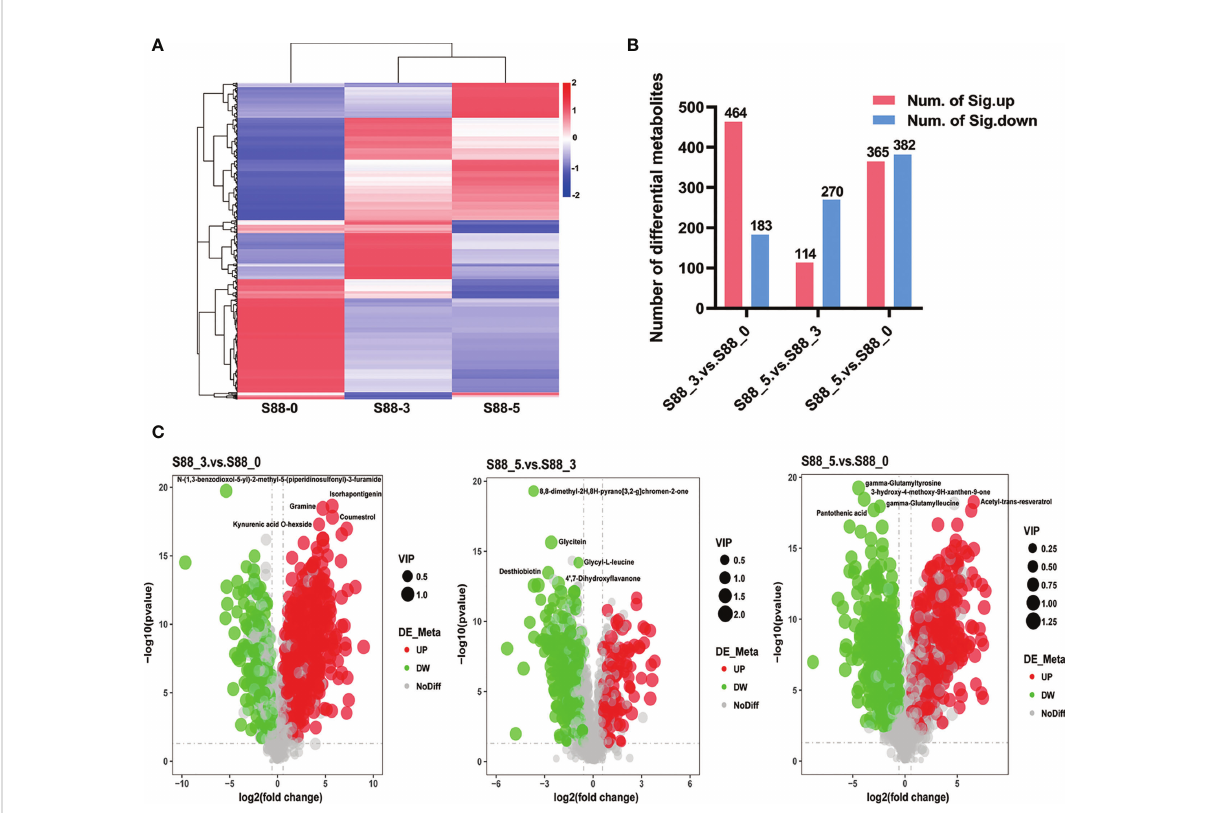
FIGURE 6 Quanti fi cation of different metabolites of soybean seeds after F. fujikuroi inoculation over time. (A) Longitudinal is the clustering of samples, and cross-sectional is the clustering of metabolites, with shorter clustering branches representing higher similarity. The cross-sectional comparison shows the relationship of the clustering of the metabolite content between groups. (B) The graphs indicate the total numbers of signi fi cant different metabolites at the corresponding comparison groups, in which red and blue bars stand for the numbers of signi fi cantly upregulated (num. of Sig. down) and signi fi cantly downregulated different metabolites (num. of Sig. down), respectively. (C) Volcano of differential metabolites; the x-axis represents the log 2 fold change of metabolites in different groups, and the y-axis represents the difference signi fi cance level (-log 10, P-value). Each dot in the volcanic map represents one metabolite; red, green, and gray dots stand for the signi fi cantly upregulated metabolites, signi fi cantly downregulated metabolites, and no different metabolites, respectively. The dot size represents the VIP